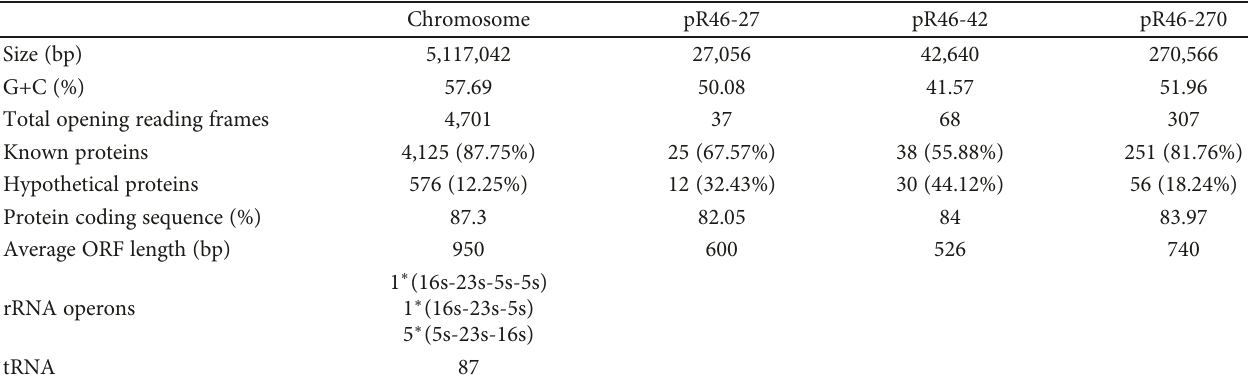
Table 3: General features of K. pneumoniae R46